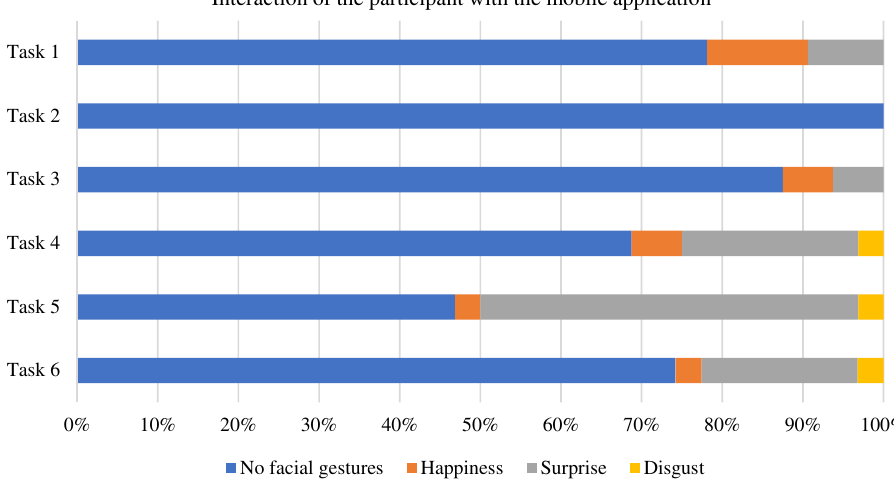
Figure 1. Interaction of the participant with the mobile